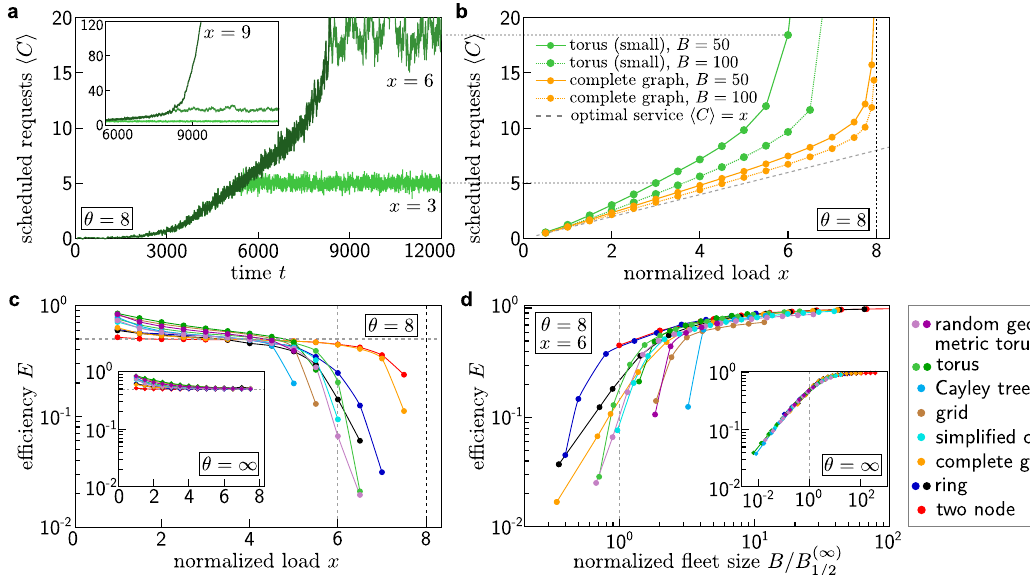
Figure 2. Capacity constraints break the topological universality of ride-pooling efficiency. ( a ) The average number (cid:31) C (cid:30) of scheduled customers per vehicle settles into a steady state for x < θ when the normalized load x [Eq. (1)] is slowly increased. If the normalized load is larger than the capacity, x > θ , the system overloads and the number of scheduled customers increases indefinitely (inset). ( b ) For small loads, the average number of scheduled customers per vehicle increases approximately linearly with the normalized load x . The difference to the best possible scaling � C � = x (dashed line) quantifies the efficiency of the service (see panels ( c ) and ( d )). When the load x approaches the capacity limit θ , the number of scheduled customers diverges as the system overloads. ( c ) Capacity-constrained systems behave qualitatively differently across network topologies when the load x approaches the capacity limit θ = 8 of the system. (inset) Systems with unlimited vehicle capacity converge to the same efficiency E for large loads x . Fleet sizes in both simulations are identical and chosen such that the efficiency E of the capacity unconstrained systems (inset) converges to E = 1 / 2 . ( d ) The efficiency curves E A ( T , B , θ , x ) of the capacity-constrained systems reveal strong differences between the various network topologies (colors), especially in settings with small fleet sizes. Neither the normalized topological factor B ( ∞ ) T ) nor a load-dependent scaling factor B T , x (cid:30) is sufficient to recover the topological universality 1 / 2 (cid:31) 1 / 2 ( observed for capacity-unconstrained systems [inset, Eq. (5)]. Colors represent different underlying networks, see “Methods” for details on the settings and